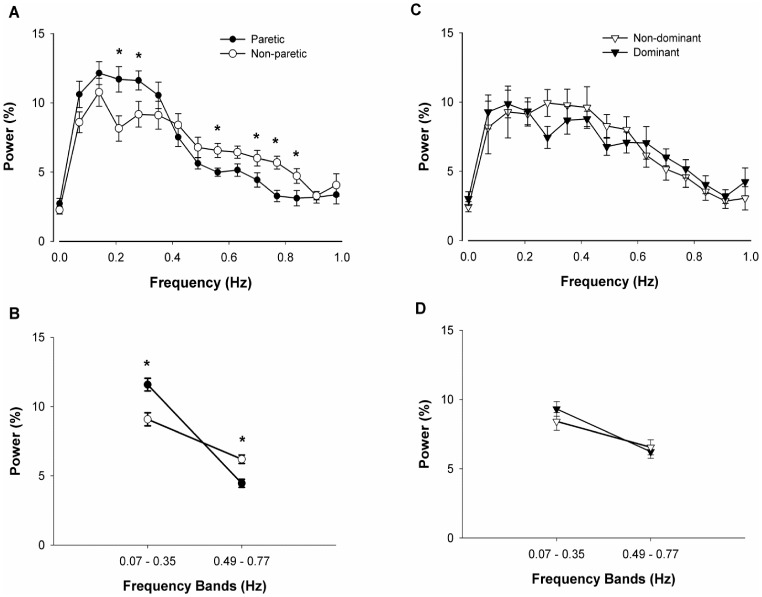
The modulation of power below 1 Hz within stroke and control groups.(A) For the stroke group, the paretic hand demonstrated significantly greater power at 0.21 and 0.28 Hz relative to the non-paretic hand (p<0.05). Further, the paretic hand showed significantly reduced power at 0.56 Hz, 0.7 Hz, 0.77 Hz and 0.84 Hz compared with the non-paretic hand (p<0.05). (B) The power in frequency bands 0.07–0.35 Hz and 0.49–0.77 Hz within stroke group. For the stroke group, the paretic hand shows greater power within 0.07–0.35 Hz (p<0.05) and reduced power within 0.49–0.77 Hz (p<0.05) relative to the non-paretic hand. (C) For the control group, the dominant hand’s power density below 1 Hz did not vary significantly from the non-dominant hand. (D) Similarly, the power in frequency bands 0.07–0.35 Hz and 0.49–0.77 Hz does not differ between the dominant and the non-dominant hand for the control group.